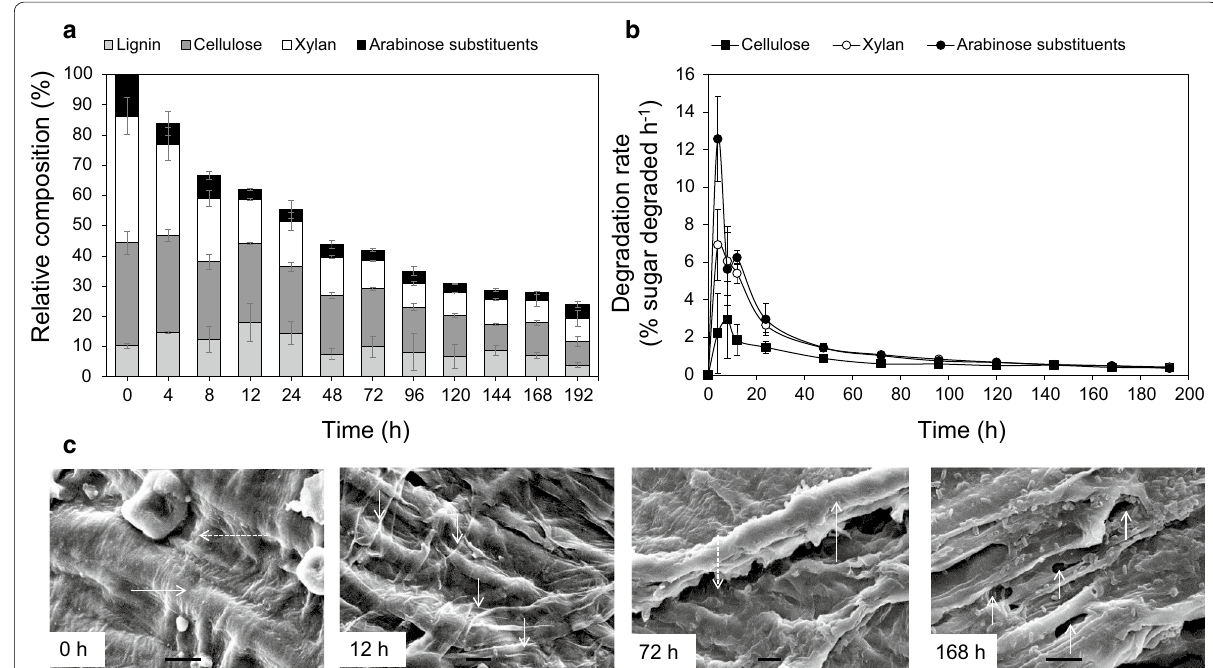
Fig. 3 Changes in composition and surface structure of the residual NMP during degradation. Composition of NMP residues during degradation ( a ). Degradation rates of NMP components ( b ). Scanning electron microscopy analysis ( c ). Time 0 h: SEM micrograph of intact NMP (1500 continuous horizontal arrow indicate the intact cellulose fiber, while the discontinuous horizontal arrow indicates the intact hemicellulose. 12 h of microbial degradation (1100 ): the short down‑arrows indicate the hemicellulose layer removal. 72 h of microbial degradation (1000 × continuous arrows indicate the exposed cellulose fiber while the vertical discontinuous arrows indicate the grooves formed in the internal matrix. 168 h of microbial degradation (1600 ): the short up‑arrows indicate the pores and cavities formed in the cellulose fibers. Scale bar ×